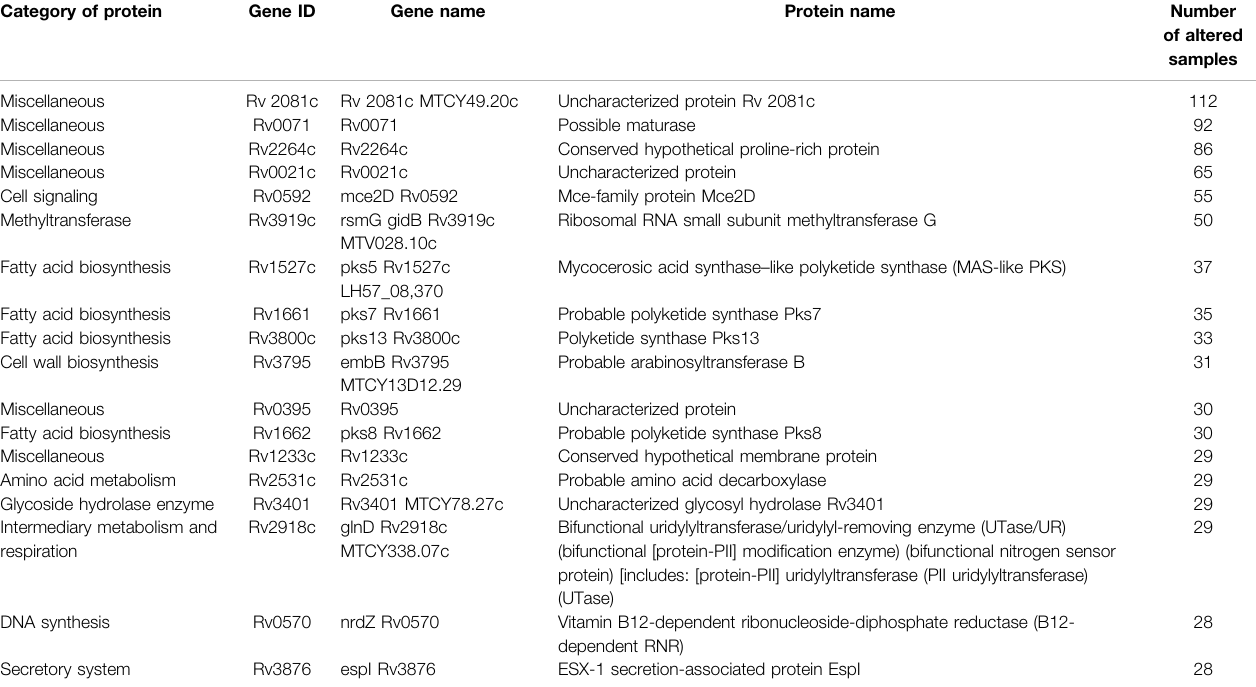
TABLE 3 | Additional list of proteins identi fi ed using MycoVarP compared to those identi fi ed by Advani et al.